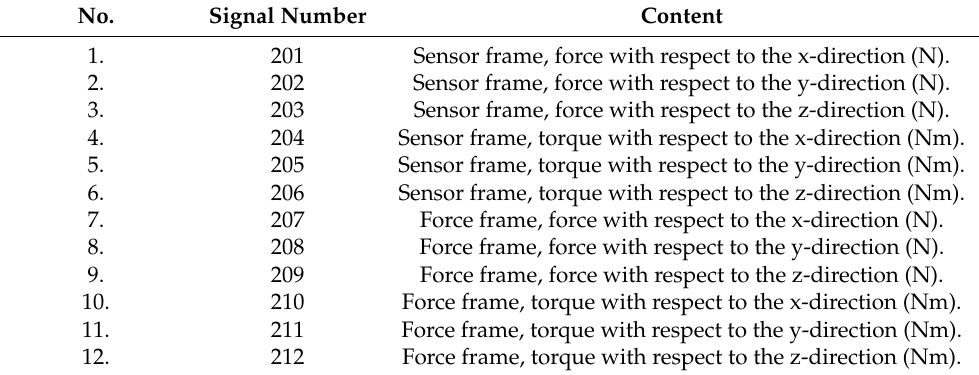
Table 1. List of test signals for the force control